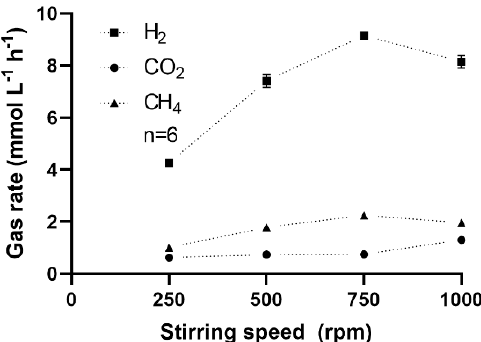
Figure 6. Effect of the stirring intensity on the consumption and formation rate of gases in a 1-L bioreactor with medium C. Bottles were pressurized at ~2.2 bar with a gas mixture of H 2 (80%) and CO 2 (20%). The rate for each stirring speed was repeated three times in duplicate biological bioreactors. Mean and standard deviation ( n = 6) are shown (invisible error bars are smaller than the symbol).